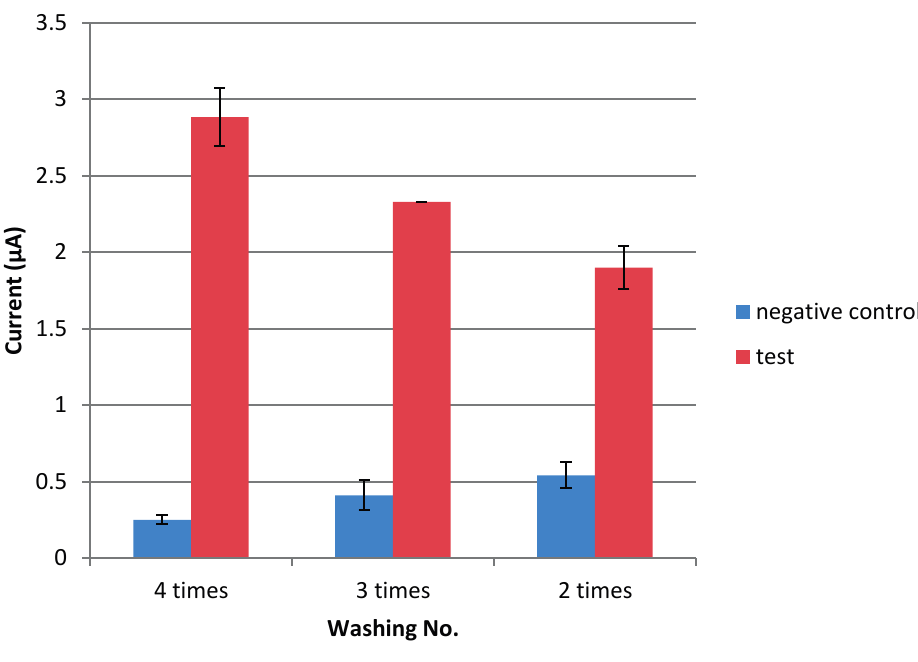
Figure 8. Optimization of washing